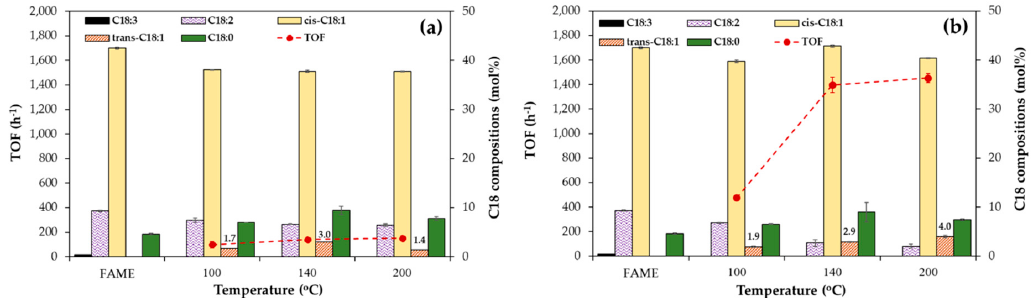
Figure 8. Effect of the reaction temperature on the degree of TOF and C18 compositions in the H-FAME obtained from the partial hydrogenation of palm oil-derived FAME over ( a ) 30 wt% Ni/SB and ( b ) 30 wt% Ni/SF catalysts under 1 bar H 2 pressure.